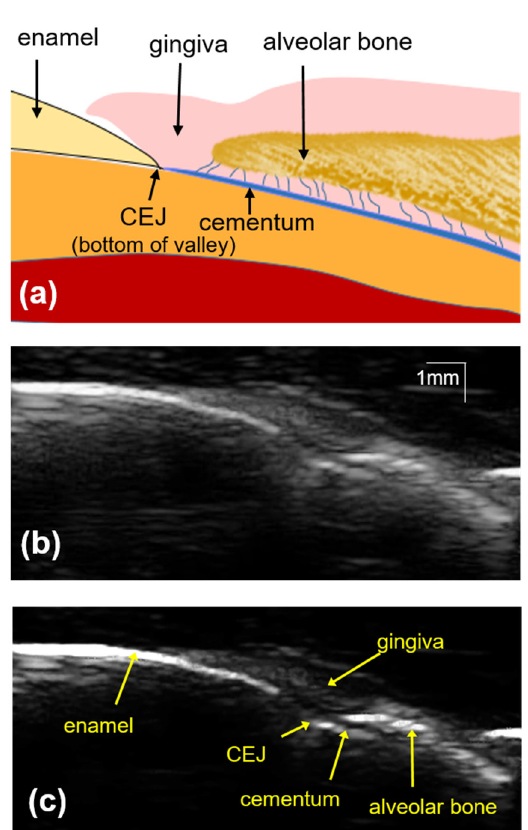
Figure 4. ( a ) A schematic cross-section of a tooth and its periodontium; ( b ) the in vivo intraoral ultrasound images before image processing; ( c ) the processed image after homomorphic filtering, contrast enhancement, and adaptive median filtering. contrast enhancement, and adaptive median